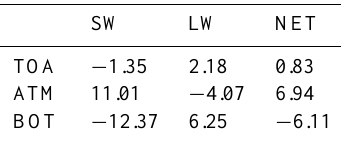
Fig. 3. Averaged diurnal cycle of upward and downward SW ra- diative fluxes at Niamey airport from the AMF retrievals and WRF- Figure 3 Averaged diurnal cycle of upward and downward SW radiative fluxes at 6 Chem simulations with and without dust Niamey airport from the AMF retrievals and WRF-Chem simulations with and without 7 dust aerosols. 8